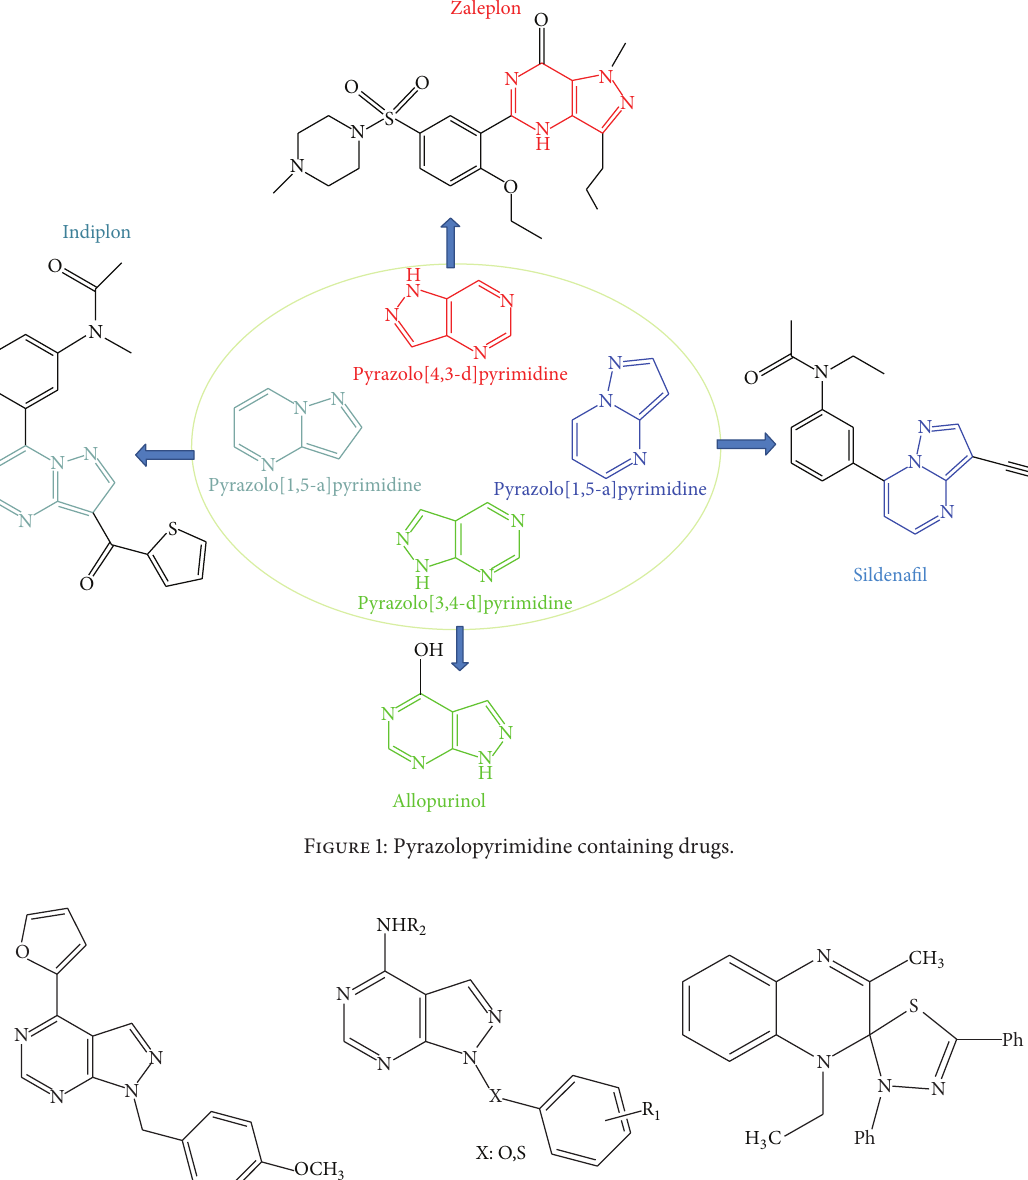
Figure 2: Example of bioactive molecules derived from pyrazolo[3,4-d]pyrimidine and thiadiazole.